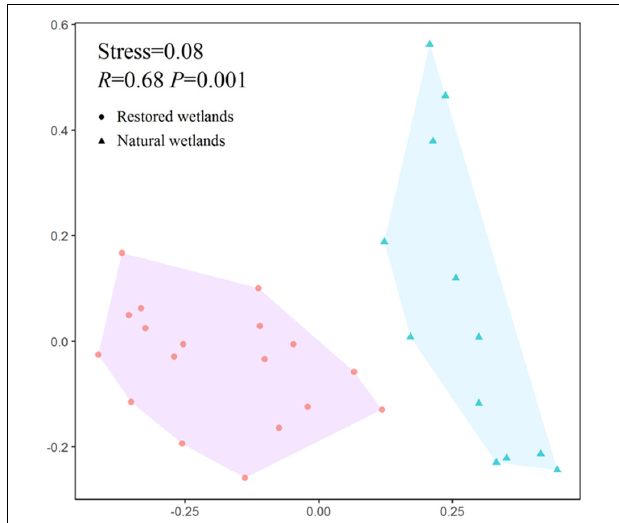
FIGURE 3 | NMDS of benthic invertebrate community composition of the Yellow River Delta based on Bray-Curtis similarities.